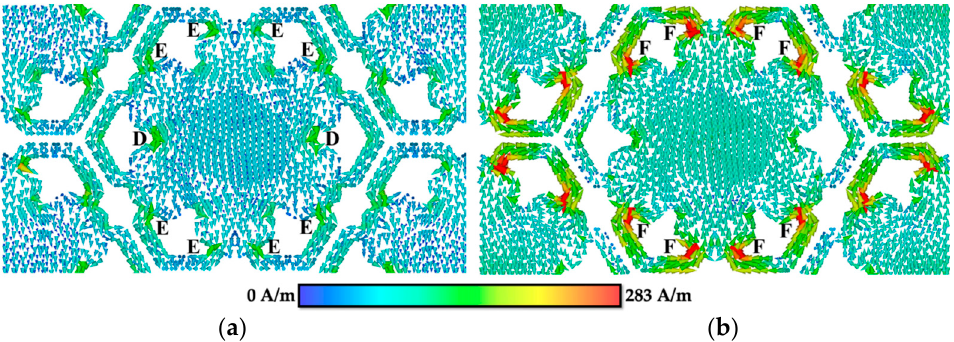
Figure 8. Surface current distribution of FSS 2 at ( a ) 26.4 GHz and ( b ) 32.54 GHz.